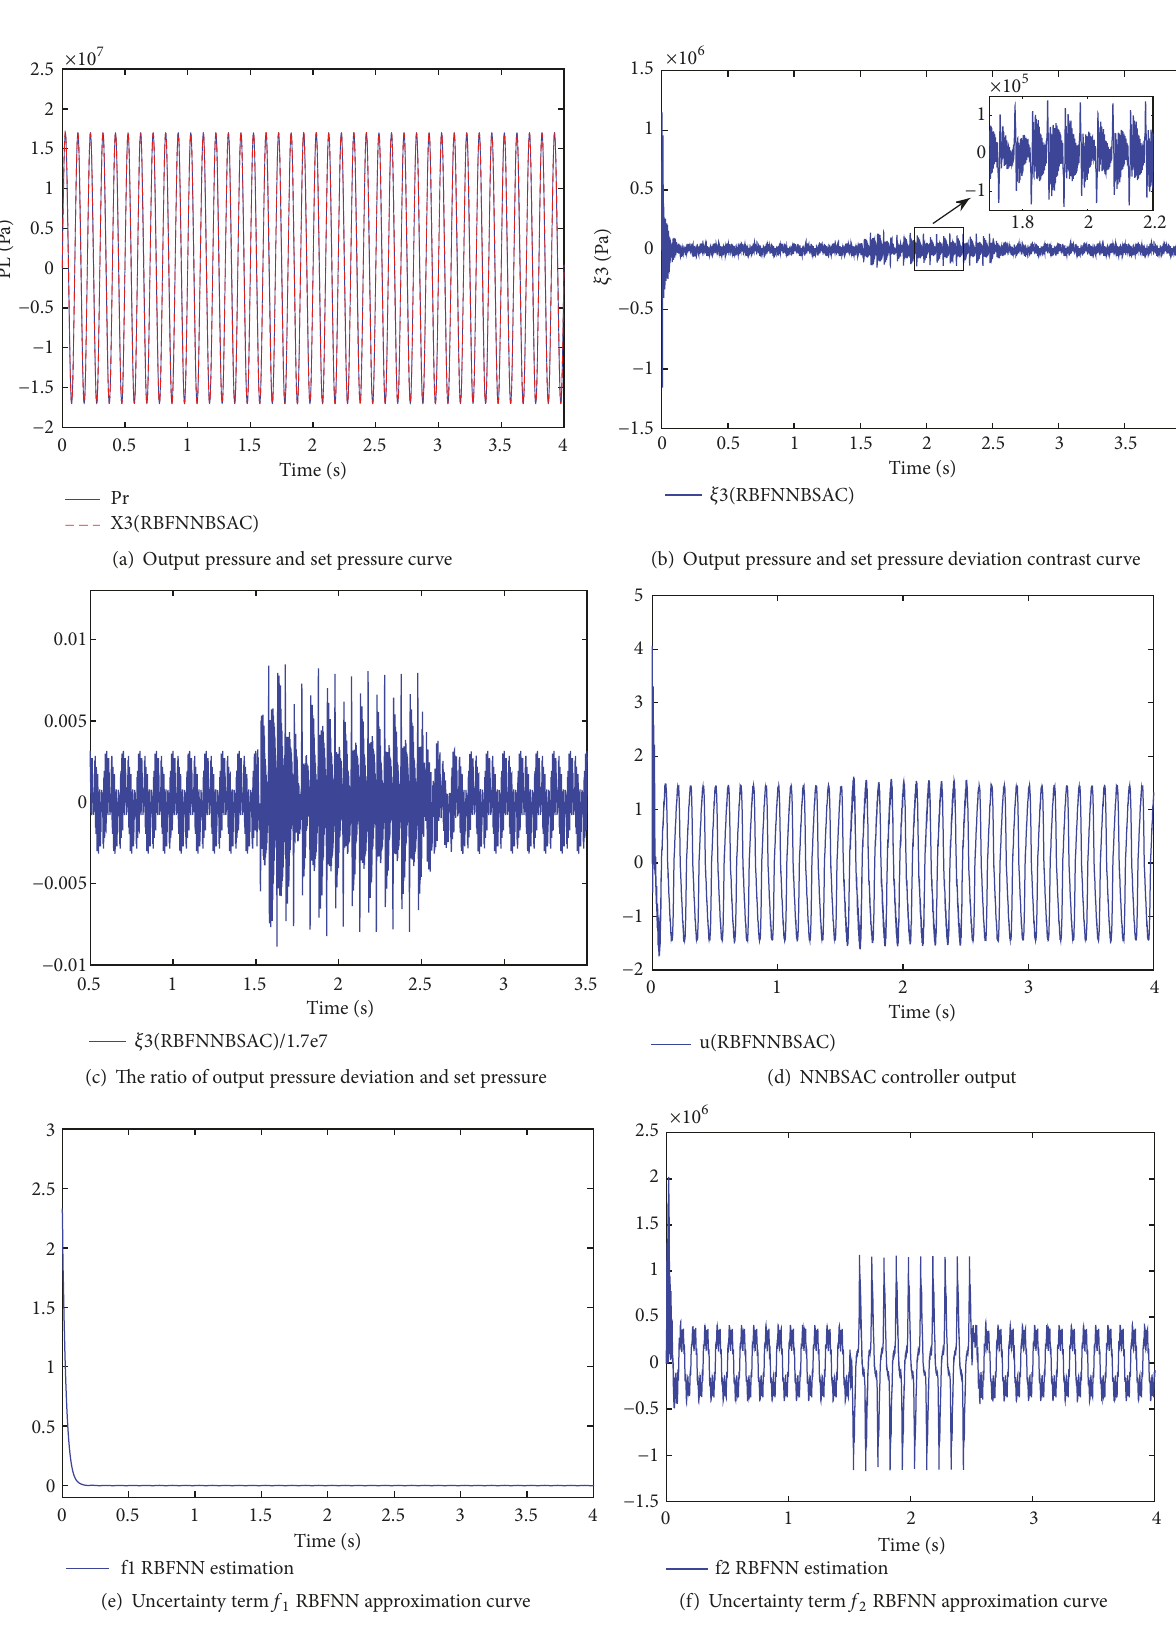
Figure 6: Dynamic pressure cylinderAMESim model RBF neural network backstepping sliding mode adaptive control interferenceresponse curve (10Hz